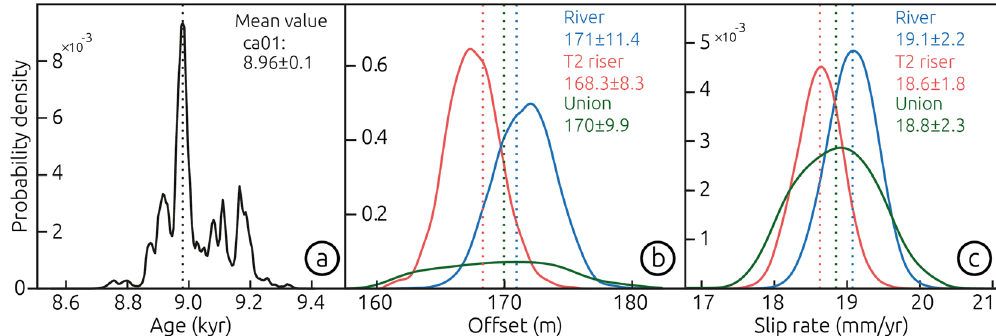
Figure 6. Slip rate of the Liquiñe Fault. ( a ) Probability distribution of the minimum abandonment age of T2 from OxCal modelling (Fig. S7). ( b ) Probability distribution for displacement estimates using T2, the bedrock river channel, and their union. C, Slip-rate distributions estimated using the method of Ref. 26 and MATLAB R2017a (www.mathw